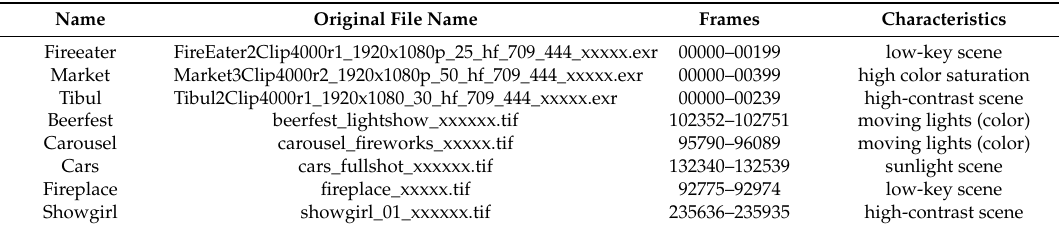
Table 1. Characteristics of the tested HDR/WCG video sequences.